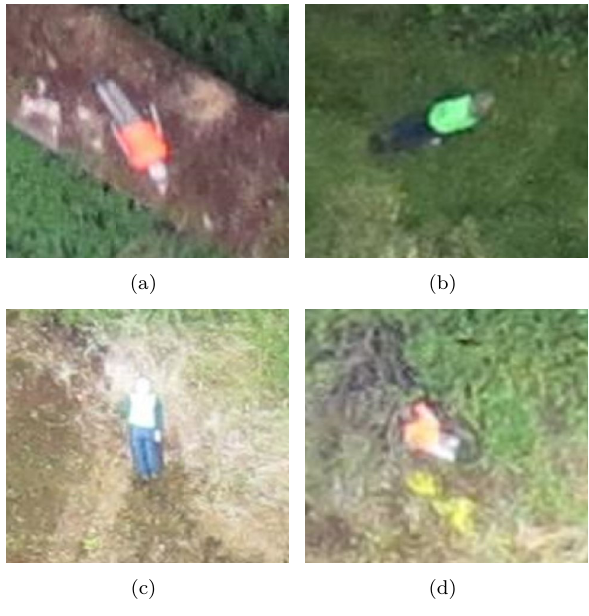
Figure 3. Four human-like dummies